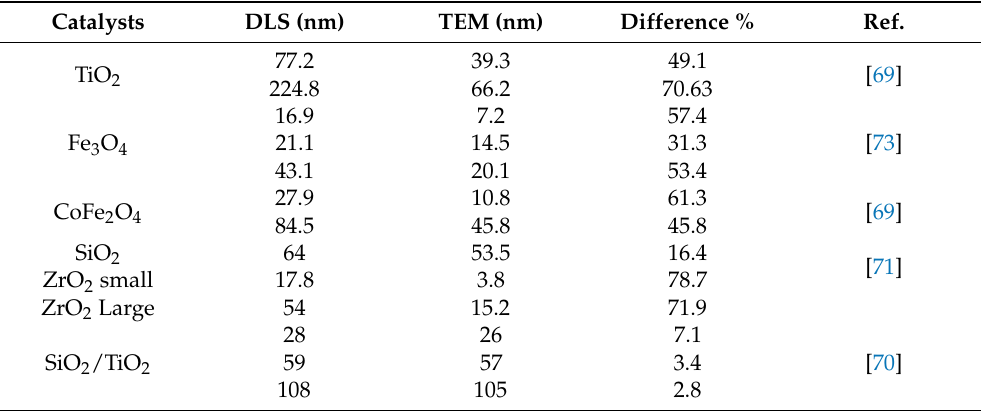
Table 5. Diameter of nanoparticles determined by DLS and